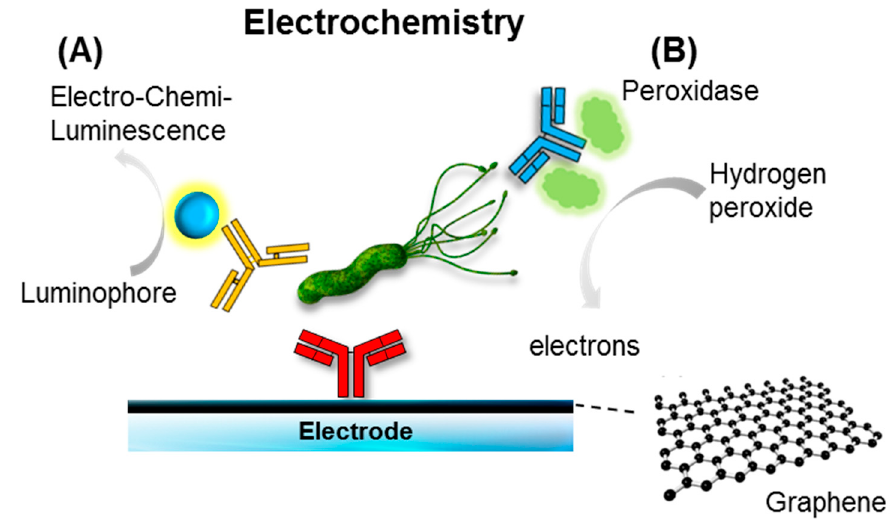
Figure 5. Schematic illustration of an electrochemical immunosensor; ( A ) a luminophore undergoes redox reaction in the electrodes with the co-reactant, producing photons that can be detected by the photodetector (e.g., a complementary metal–oxide–semiconductor (CMOS) and charge coupled device(CCD)); ( B ) similar to a common glucose sensing biosensor, electrons can be produced via enzyme catalytic reaction (e.g., peroxidase), which is labeled with the antibody in the presence of the substrate (e.g., hydrogen peroxide). Graphene, a carbon allotrope (in the form of honeycomb), was recently used as a supporting matrix for enhancing electrical performance.